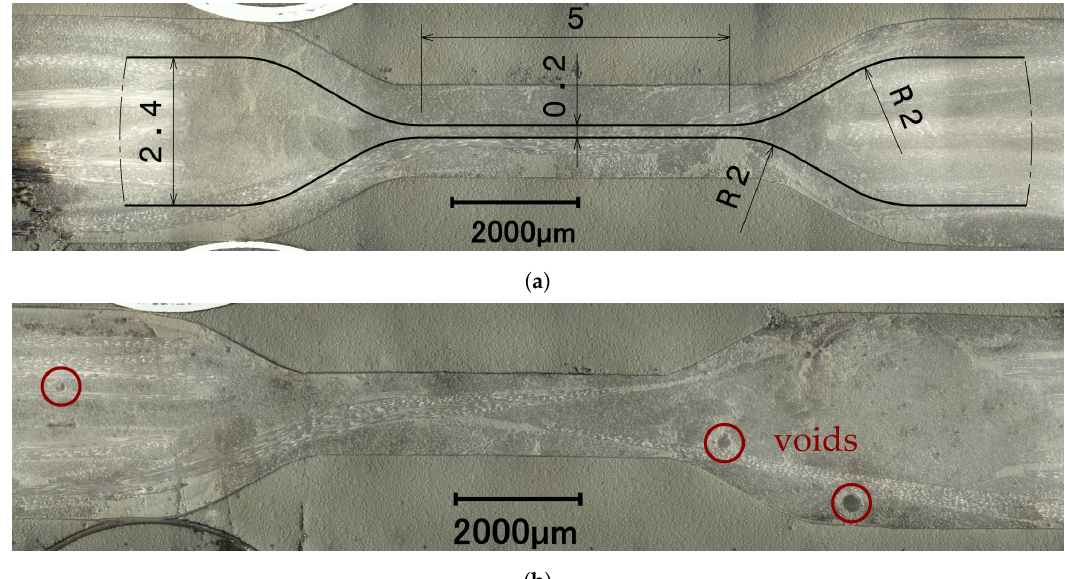
Figure 15. Microscope images of woven flexure hinges: Weave trials with 300 tex PA weft thread in hinge areas: ( a ) Twisted yarn/Twisted yarn. ( b ) TecTape/Twisted